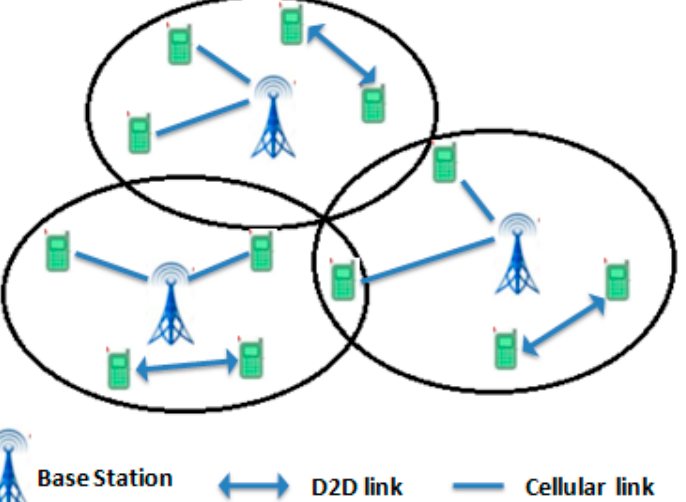
Figure 1. The system model of underlaid with D2D communication.